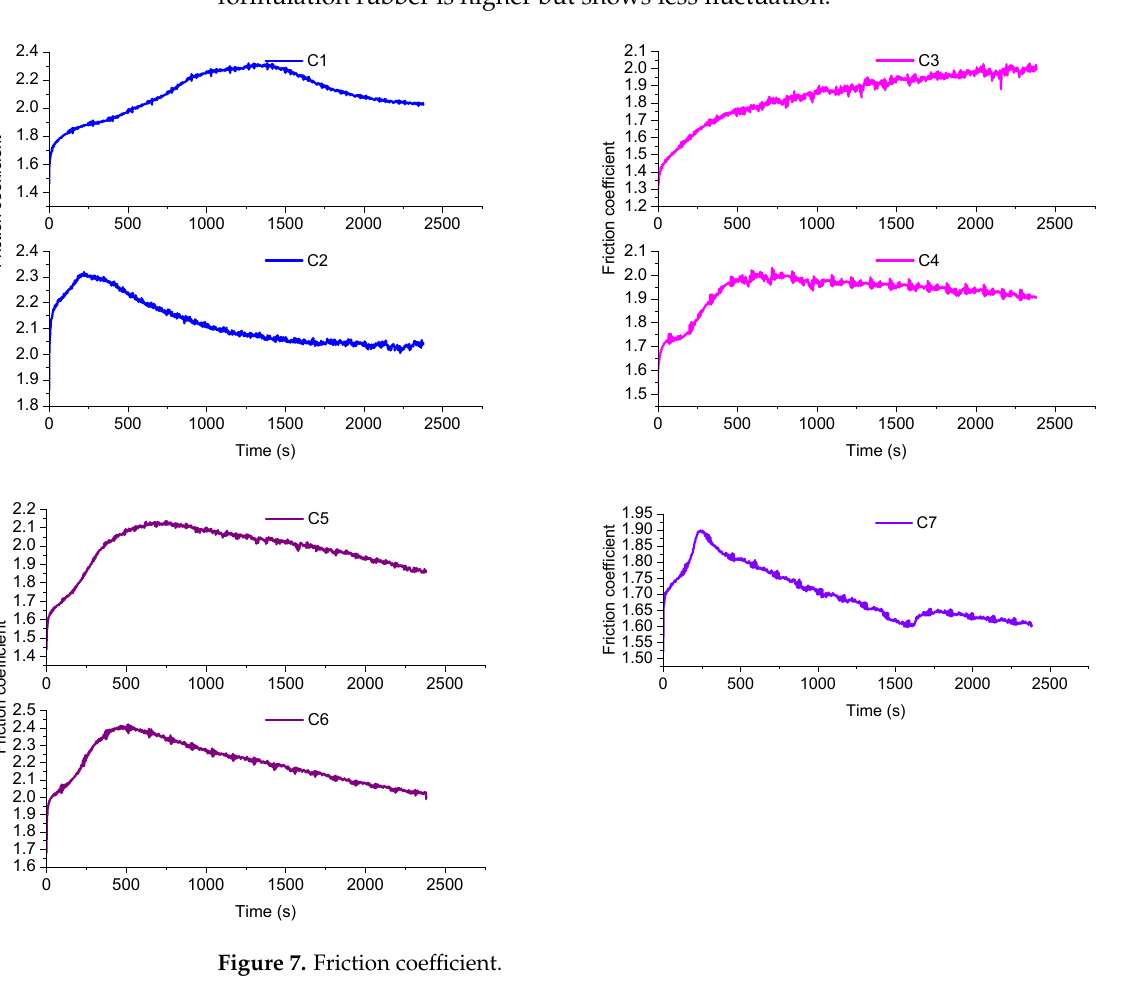
Figure 7. Friction coefficient.